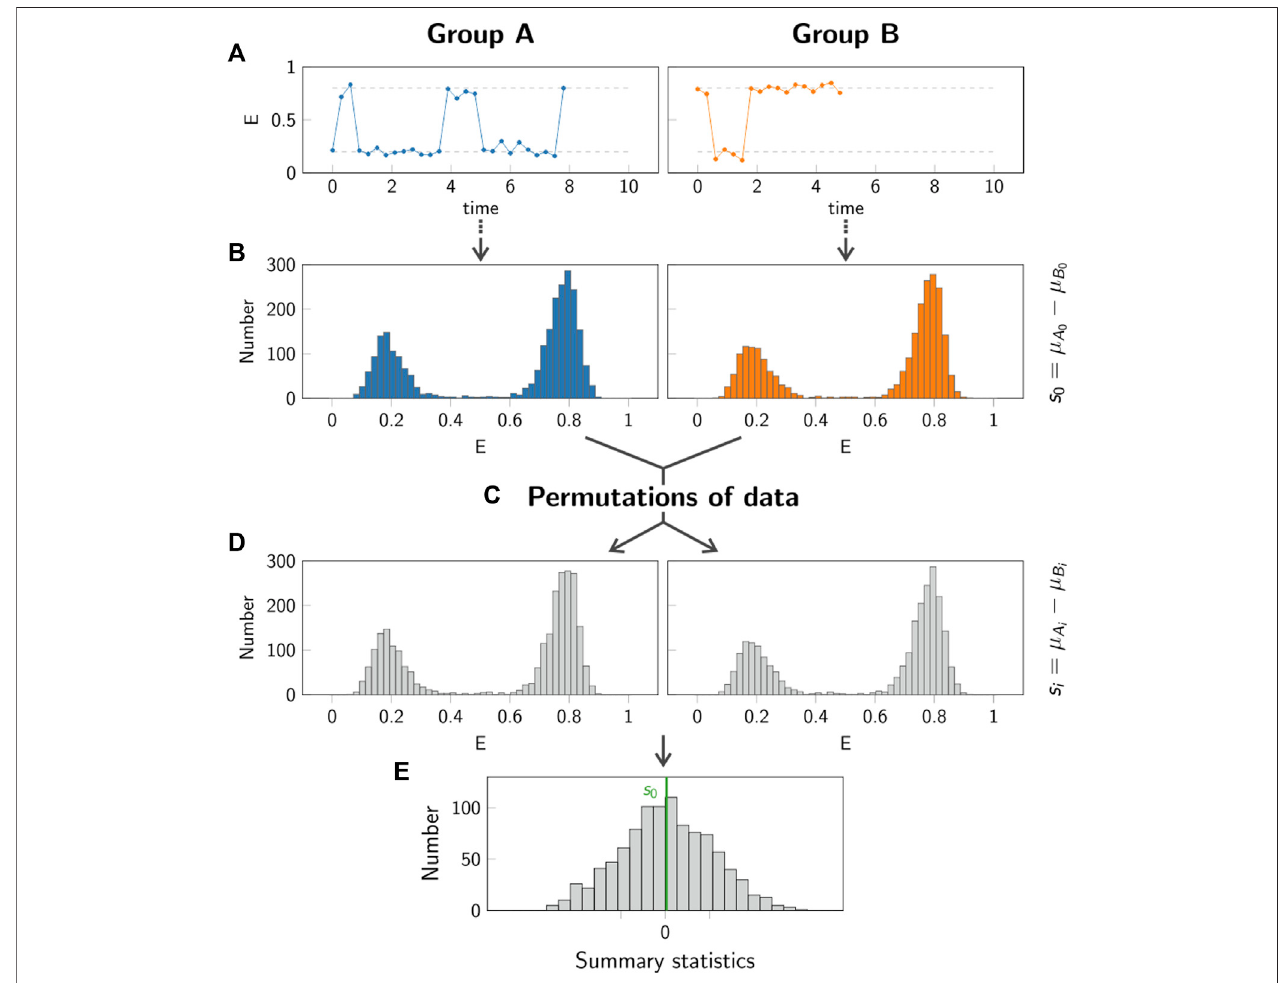
FIGURE 9 | Principle of permutation test. In the permutation test, the group A (left column, blue) is compared to the group B (right column, orange). Step (A) : Individual single molecule trajectories are recorded for both groups A and B . Step (B) : The data obtained from all trajectories in each group is pooled. The summary statistics s 0 is calculated in order to compare the two groups. Step (C,D) : Random permutations of the data in the two groups are generated, yielding new samples A i and B i . For each permutation, the summary statistics s i is calculated. Step (E) : The p -value is obtained by comparing the value s 0 (green line) to the values s i obtained for 1000